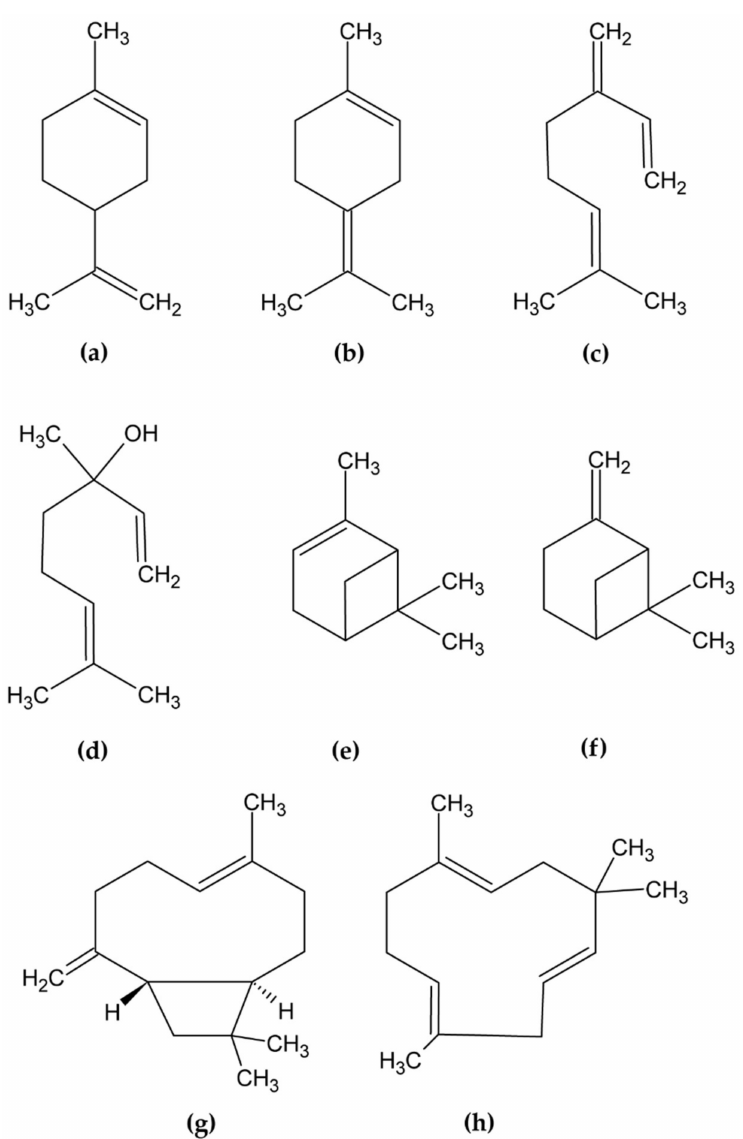
Figure 1. Structures of the investigated compounds: ( a ) limonene, ( b ) terpinolene, ( c ) myrcene, ( d ) linalool, ( e ) α -pinene, ( f ) β -pinene, ( g ) β -caryophyllene, ( h )